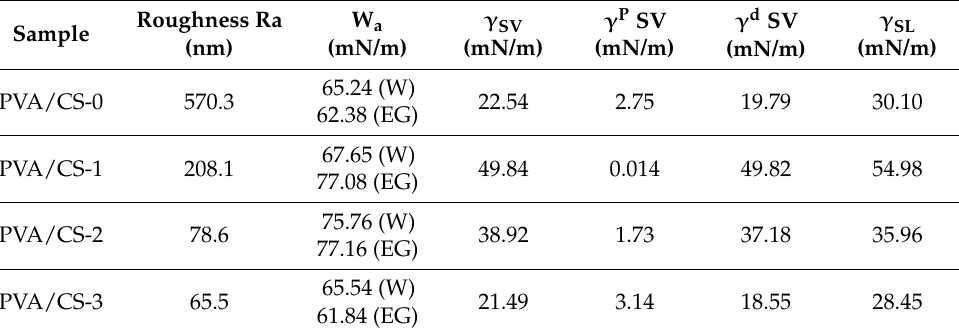
Table 2. Surface tension parameters of the test liquids used in contact angle measurements performed on PVA/CS composite